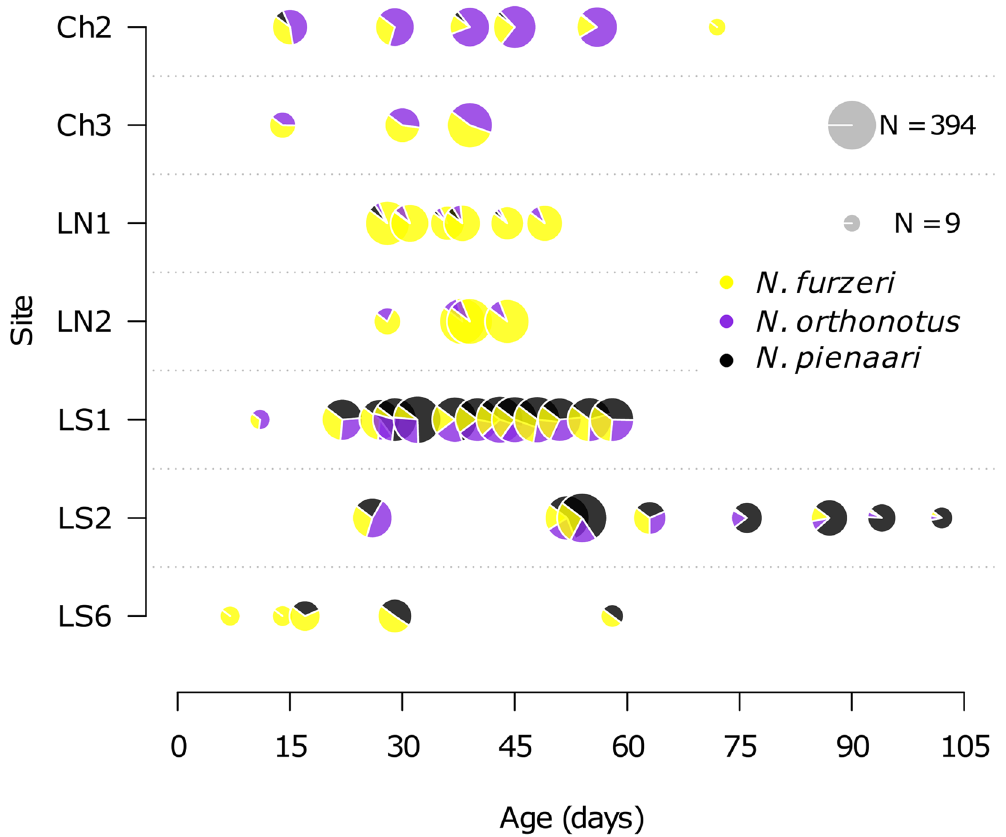
Figure 5. Proportions of up to 3 sympatric Nothobranchius species at 7 study sites throughout the season. The size of a pie gives number of fish in Total catch at each visit, thereby not necessarily showing population abundance. Note that only sites with 10 individuals captured per species at least once are